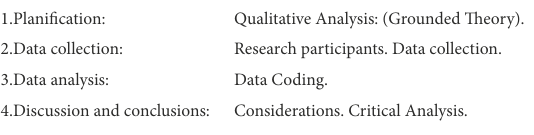
TABLE 1 Methodological phases of the research